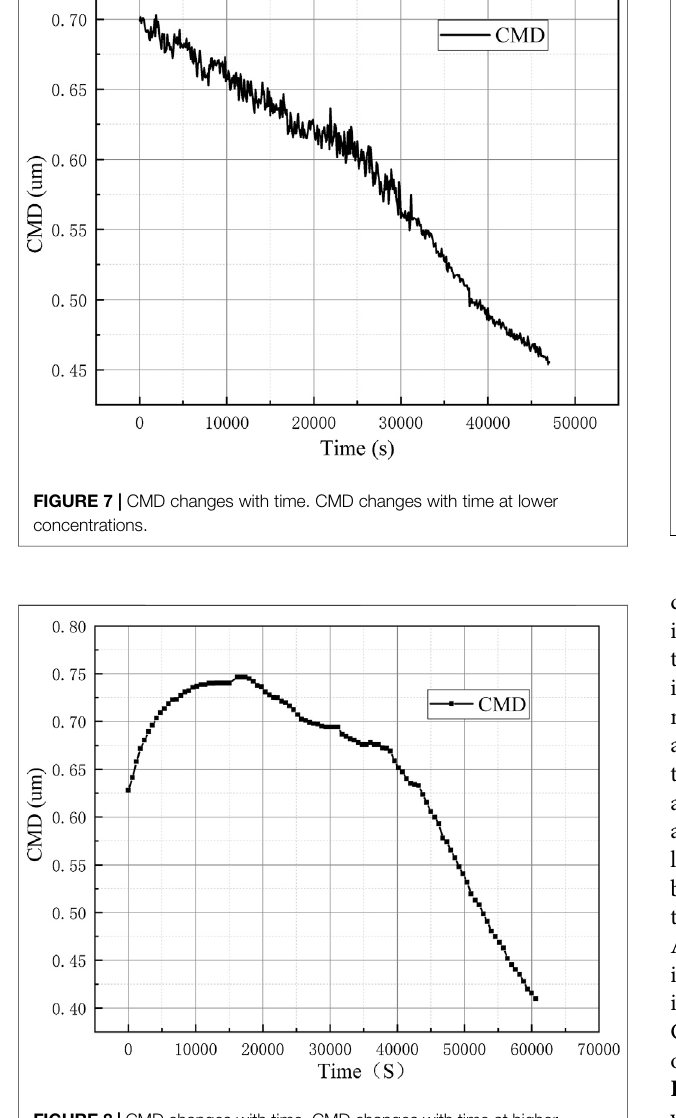
FIGURE 8 | CMD changes with time. CMD changes with time at higher concentrations.